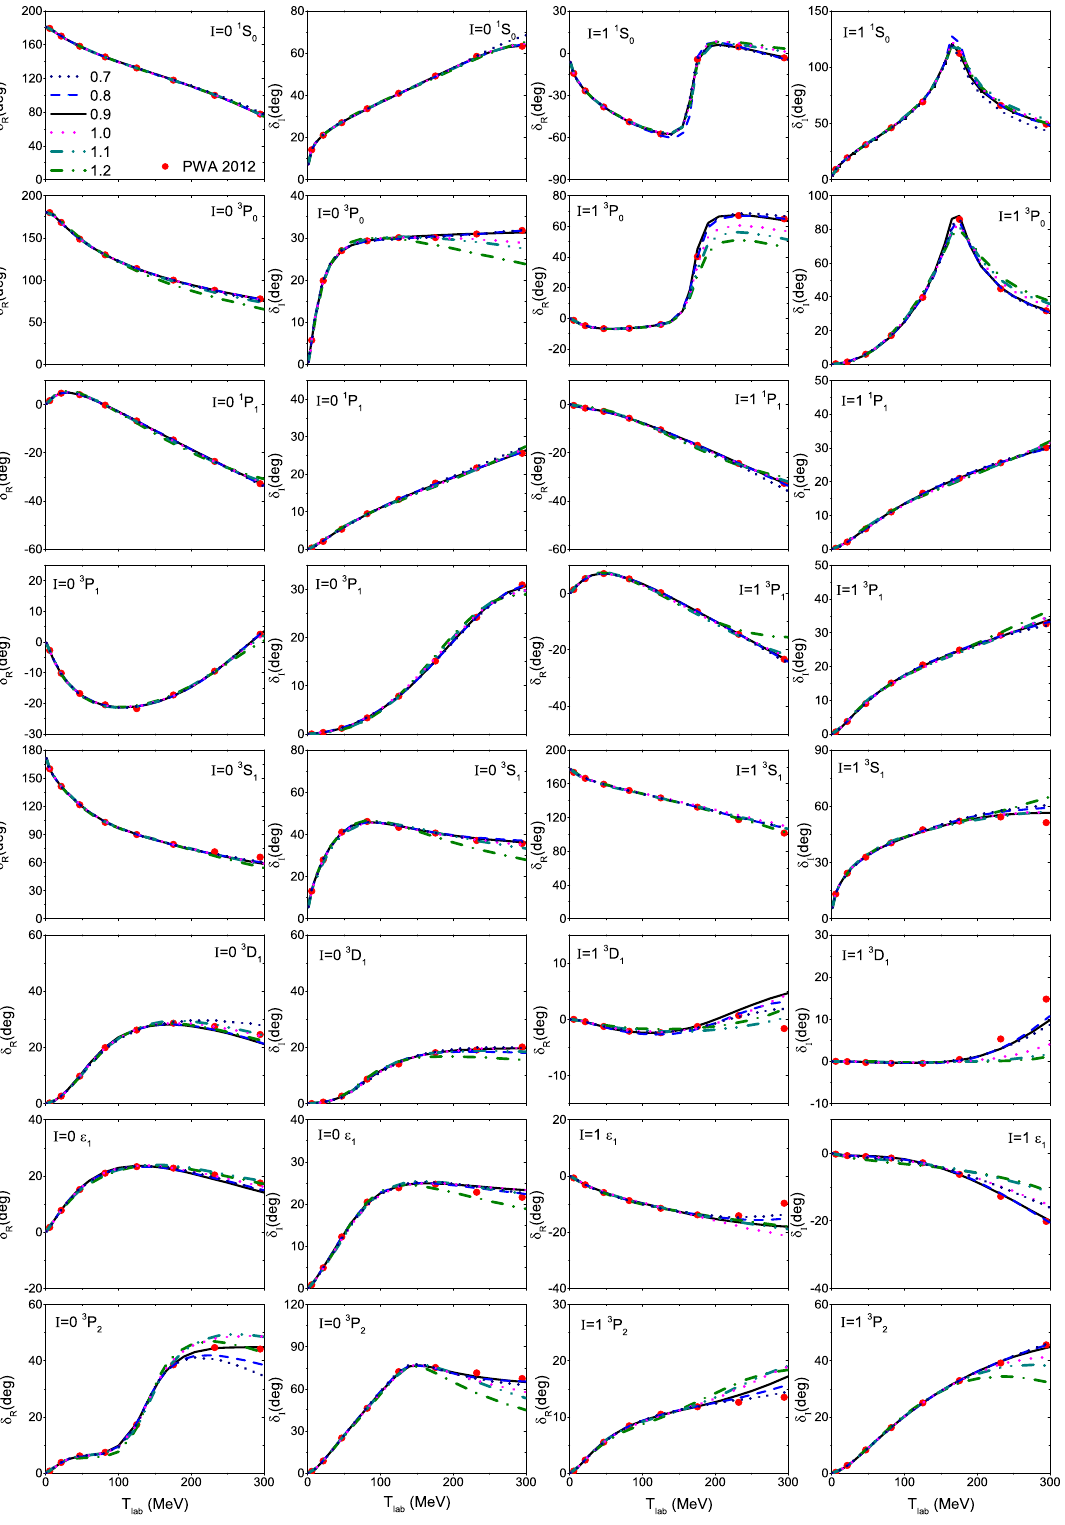
Figure 2 . Real and imaginary parts of various (cid:22) NN phase shifts at N 3 LO for cuto(cid:11)s R = 0 : 7{1 : 2 fm. The (cid:12)lled circles represent the solution of the (cid:22) pp PWA